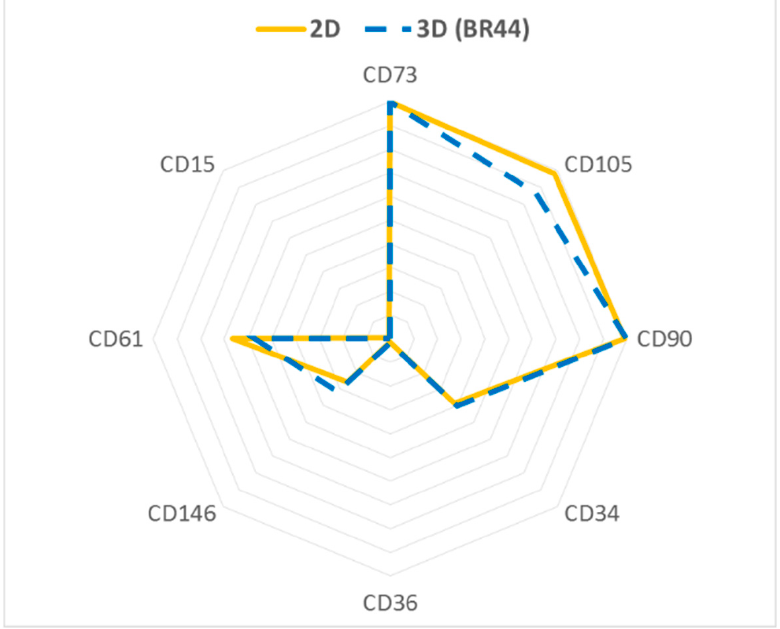
Figure 9. Flow cytometry data were summarized and depicted using a “Radar Plot” for ASC52telo cells cultured in xeno- and serum-free conditions ( UrSuppe ). The diagram shows the percentage of positive cells for the respectively indicated surface marker. Cells were cultured either in 2D (T25 flask) or on the BR44 (3D condition).